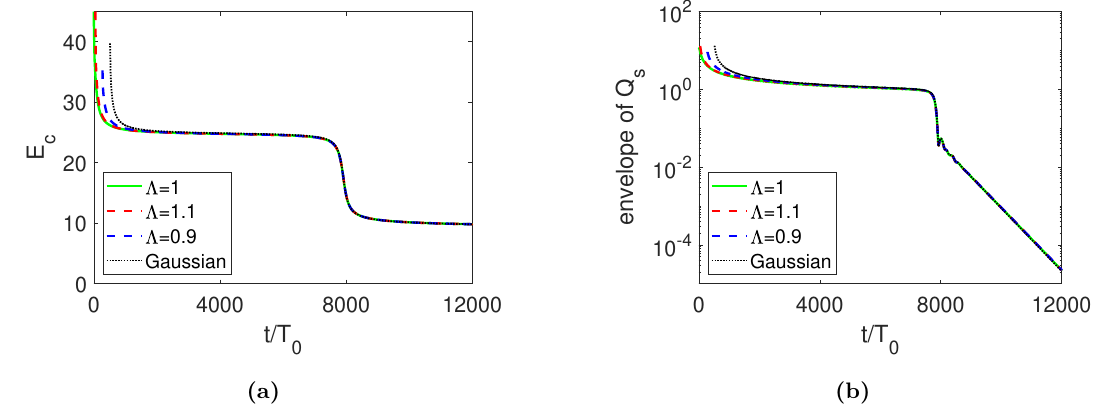
Figure 22. Evolution of energy E c and charge Q s for deformed CSQs. The deformation is done by multiplying the profile f ( r ) of the constituent elementary Q-ball by a factor of Λ , Λ = 1 being the un-deformed elementary Q-ball. Different cases are shifted to match the fast decay stages. We see that different initial configurations are attracted to the same quasi-stable CSQ